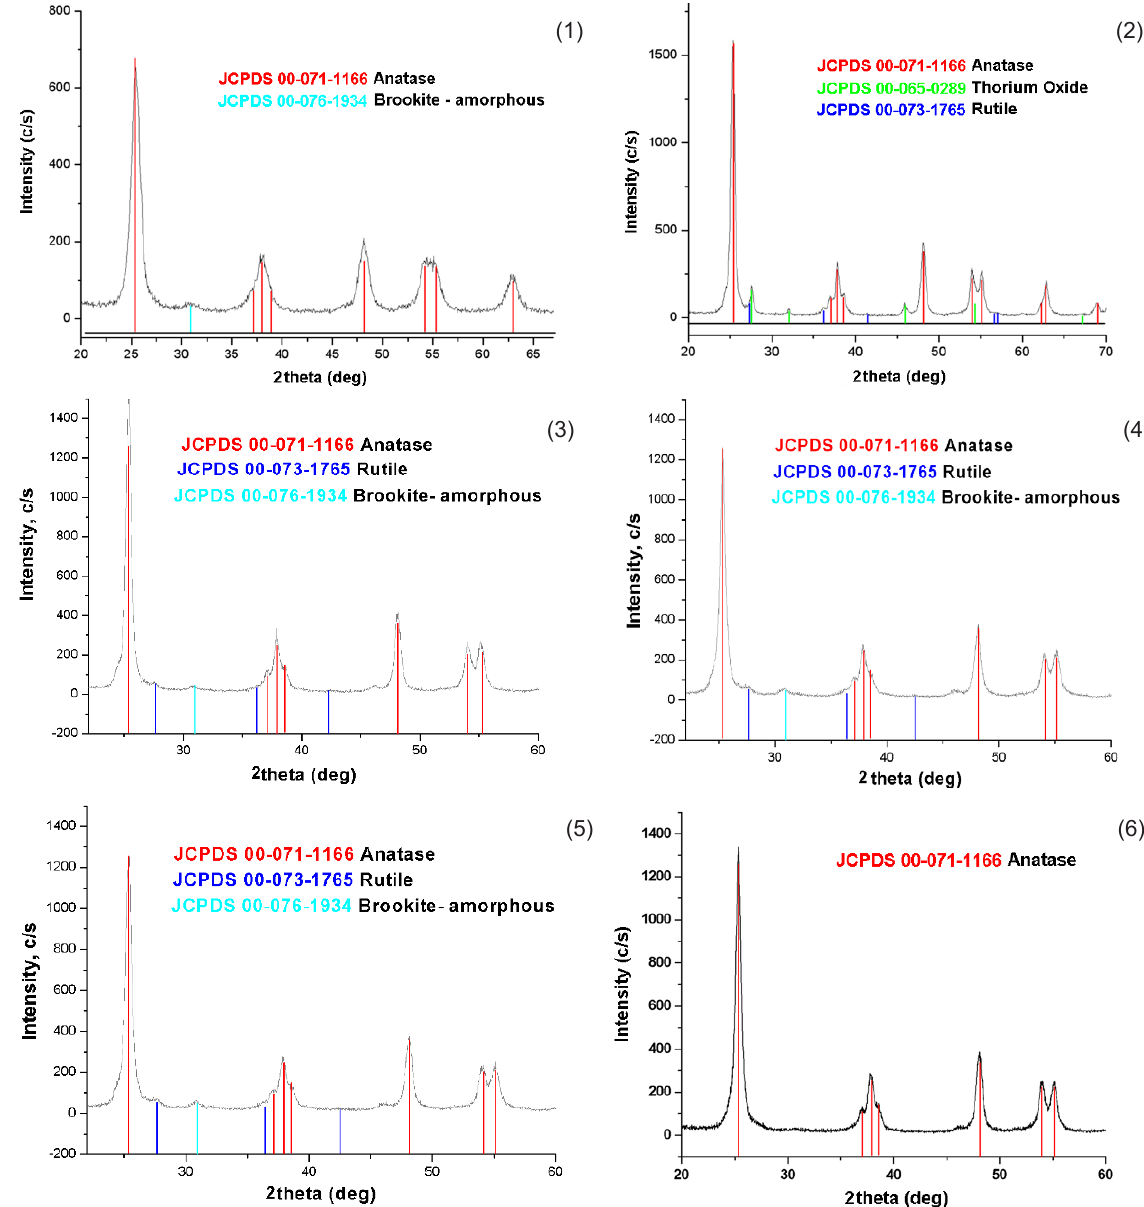
Figure 1. X-ray diffractograms of TiO